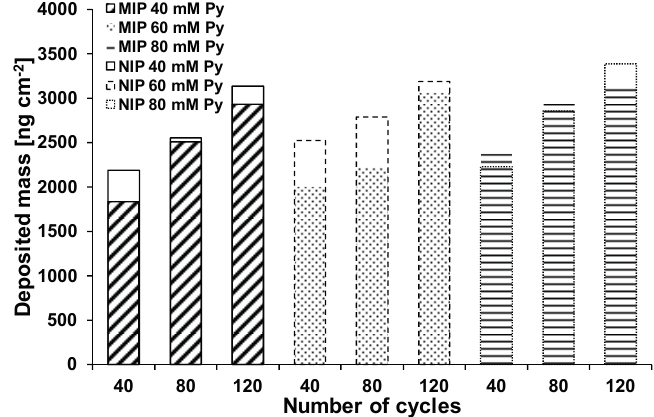
Figure 3. Deposited mass of polypyrrole obtained in phosphate buffer (blank columns NIP; filled columns MIP; in all experiments: 1 mM clofibric acid, Py: pyrrole). For nine MIPs made with 40 mM pyrrole and 120 cycles, 2.7 ± 0.2 µg·cm − 2 (18 ± 1.3 nm)